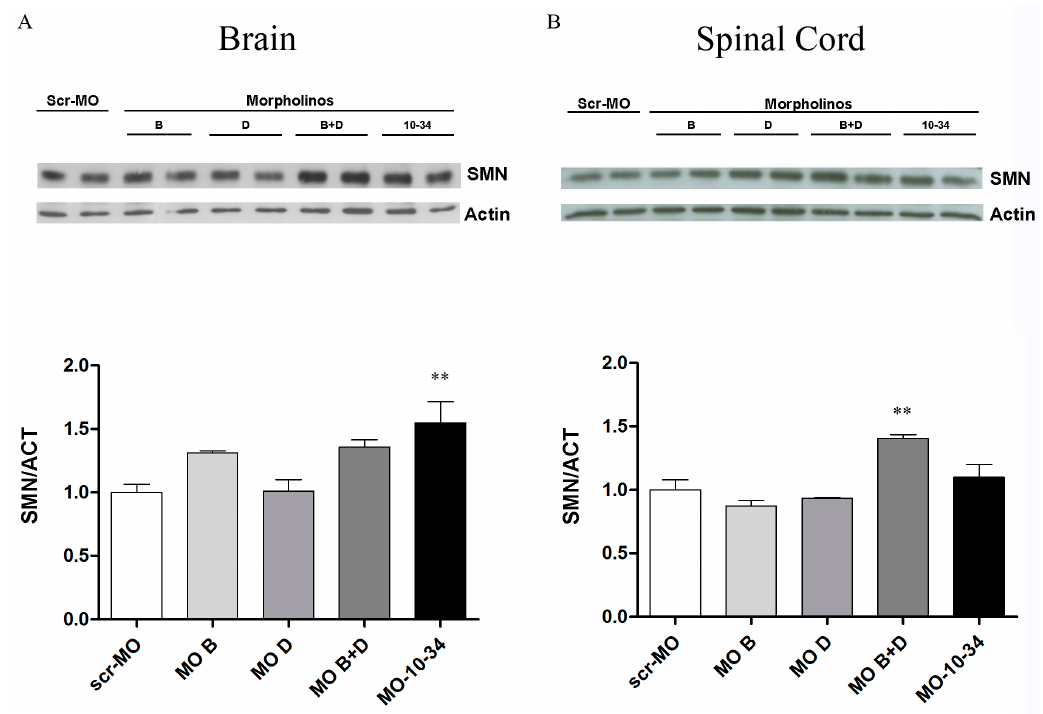
Figure 4. New MO sequences are able to upregulate the SMN protein in heterozygous SMA mice. ( A ) A representative image of western blot and densitometry analyses of brain samples from heterozygous SMA mice treated with different MO sequences shows that the efficacy of co-administration of MO B + MO D was high, even if not as high as MO-10-34 (** p < 0.01); ( B ) A representative image of western blot and densitometry analyses of spinal cord samples from heterozygous SMA mice treated with different MO sequences shows that co-administration of MO B + MO D was more efficacious than treatment with other sequences, even more so than treatment with MO-10-34 ( p < 0.01). The values represent the means + SEM. Scr-MO: scrambled-MO.